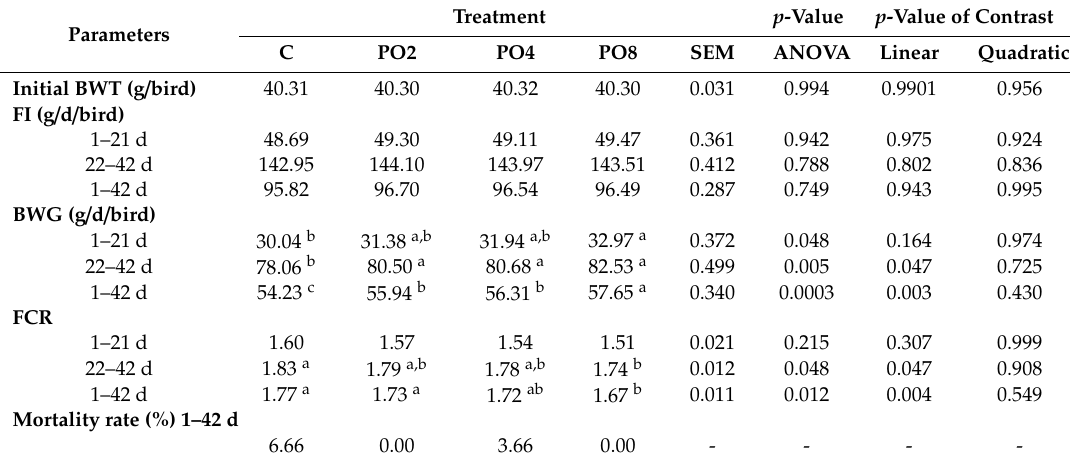
Table 2. E ff ects of di ff erent doses of supplementation of Persicaria odorata leaf meal (POLM) on the growth performance of broiler